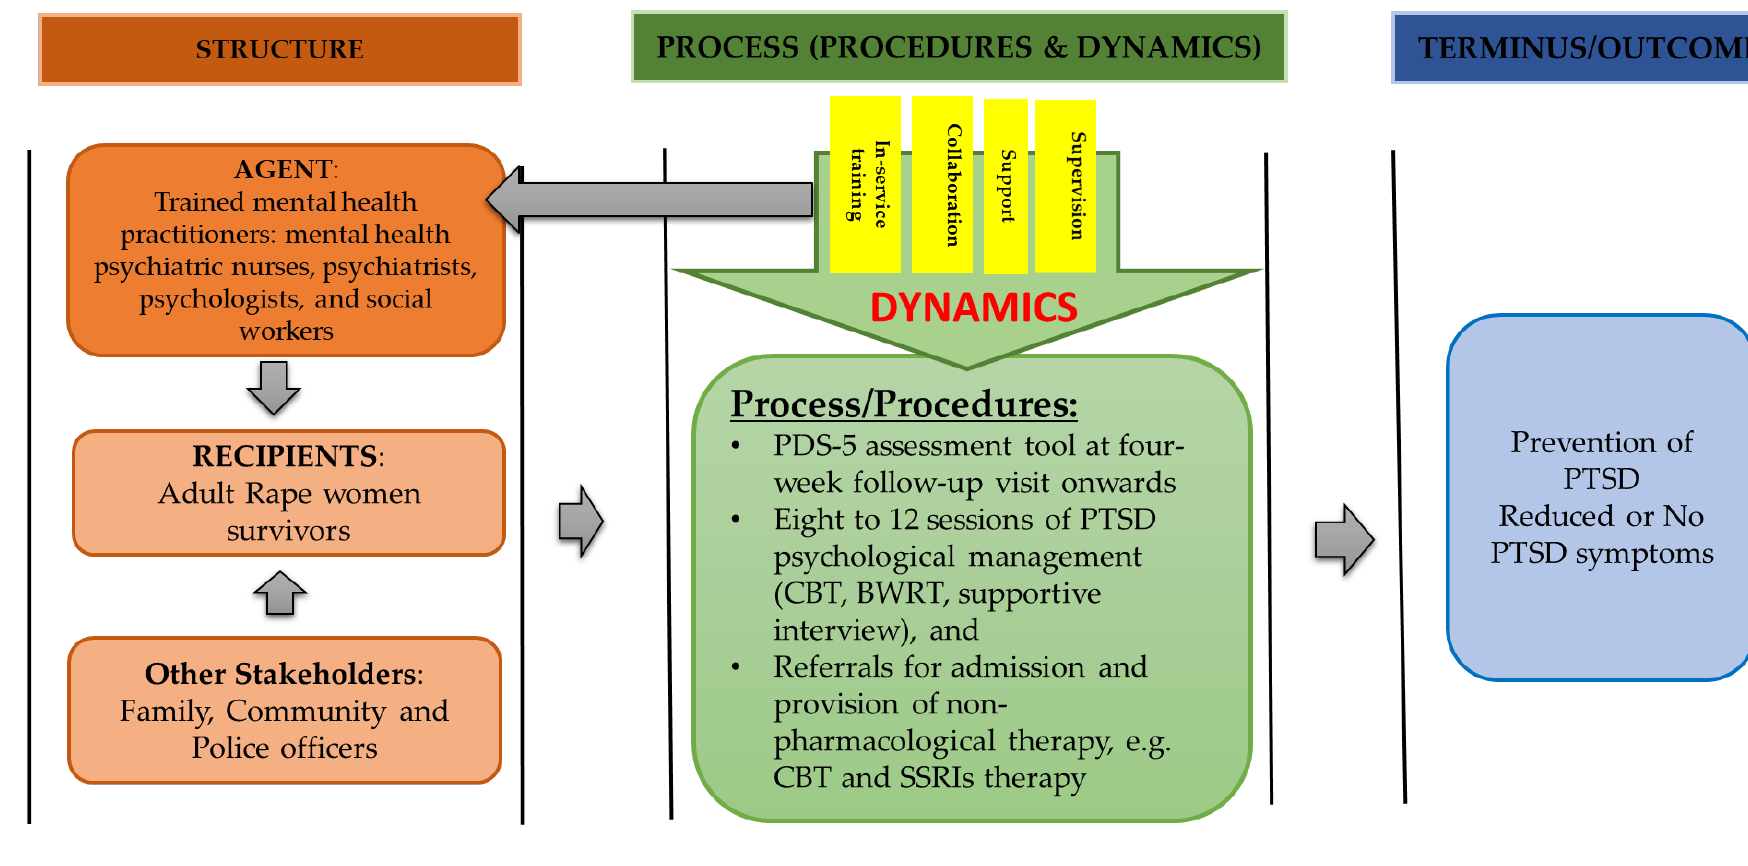
Figure 1. A conceptual framework for assessment and management of adult rape women survivors diagnosed with PTSD in TCCs and public mental health care facilities.